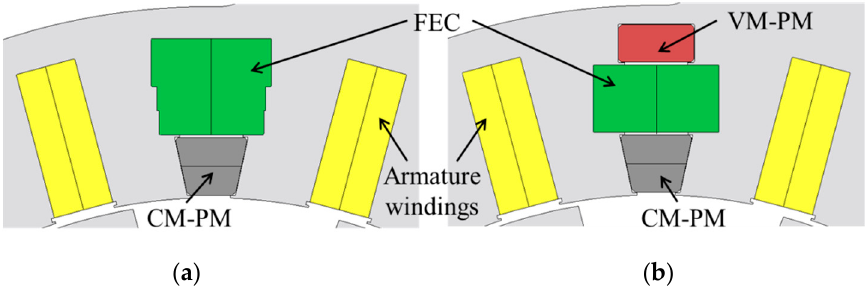
Figure 6. Comparison of stator major parts between the conventional and the new hybrid excitation flux switching motors (HEFSM). ( a ) conventional HEFSM; ( b ) newly designed HEFSM with VM-PM. ©2020 IEEE. Reprinted with permission, from K. Otsuka, T. Okada, T. Mifune, H. Matsumori, T. Kosaka and N. Matsui, Proceeding of 2020 IEEE Energy Conversion Congress and Exposition (ECCE), IEEE,